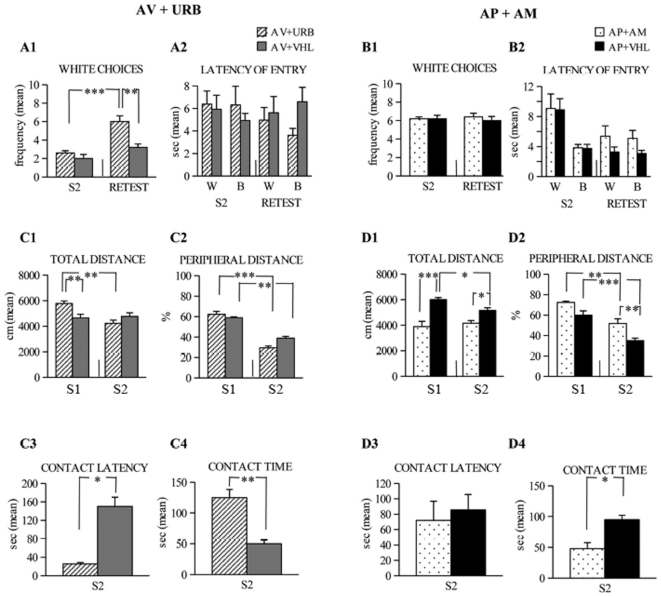
Behavioral responses of avoiding (AV) and approaching (AP) mice in A/A Y-Maze and OF.On the left side, the responses of AV animals treated with URB597 (URB) or vehicle (VHL) in A/A Y-Maze (A1, A2) and OF (C1–C4). AV+URB animals displayed enhancement of white choices and decrease of entry latencies mainly in entering the black arm, while they were more active in exploring the environment and contacting the object in the OF than AV+VHL animals. On the right side, the responses of AP animals treated with AM251 (AM) or vehicle (VHL) in A/A Y-Maze (B1, B2) and OF (D1–D4). AP+AM did not change the number of white choices, decreased entry latencies in the white arm in A/A Y-Maze, while they were less active in exploring the environment and contacting the object in the OF than AP+VHL animals. Abbreviations: W: white arm; B: black arm; S1: first session; S2: second session. Asterisks indicate the significance level of the post hoc comparisons between groups: * P<0.05; ** P<0.005; *** P<0.0005.